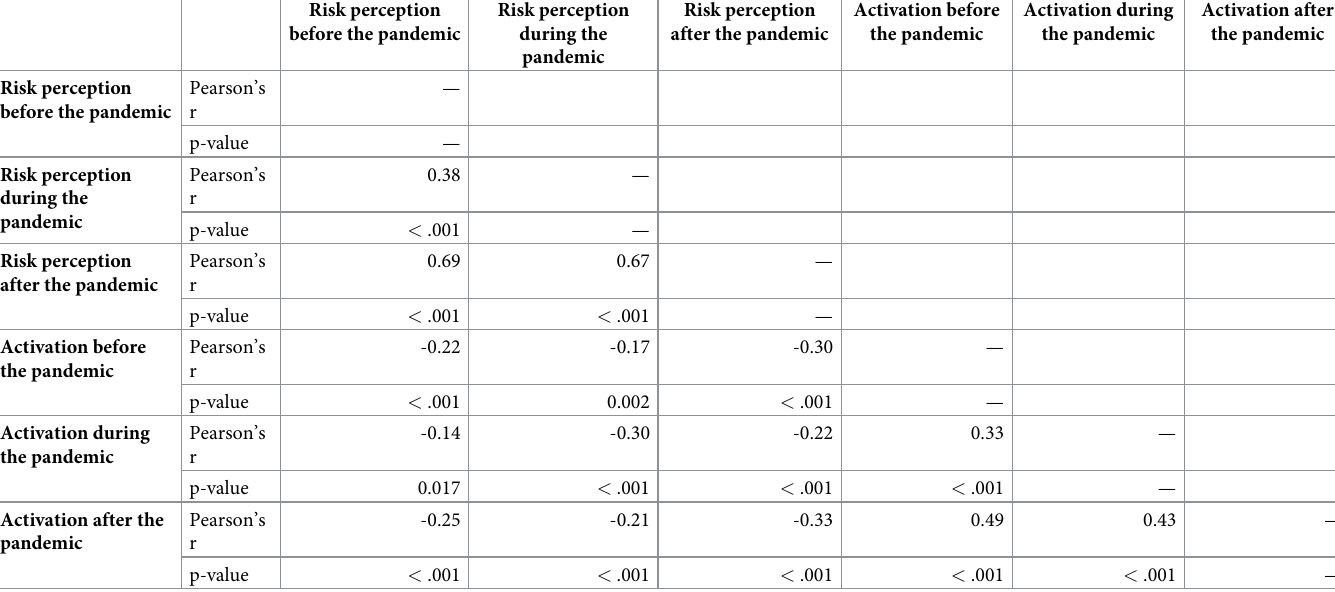
Table 9. Correlation matrix with Pearson’s correlations among risk-perception measures and STS activation dimension over time. Risk perception before the pandemic